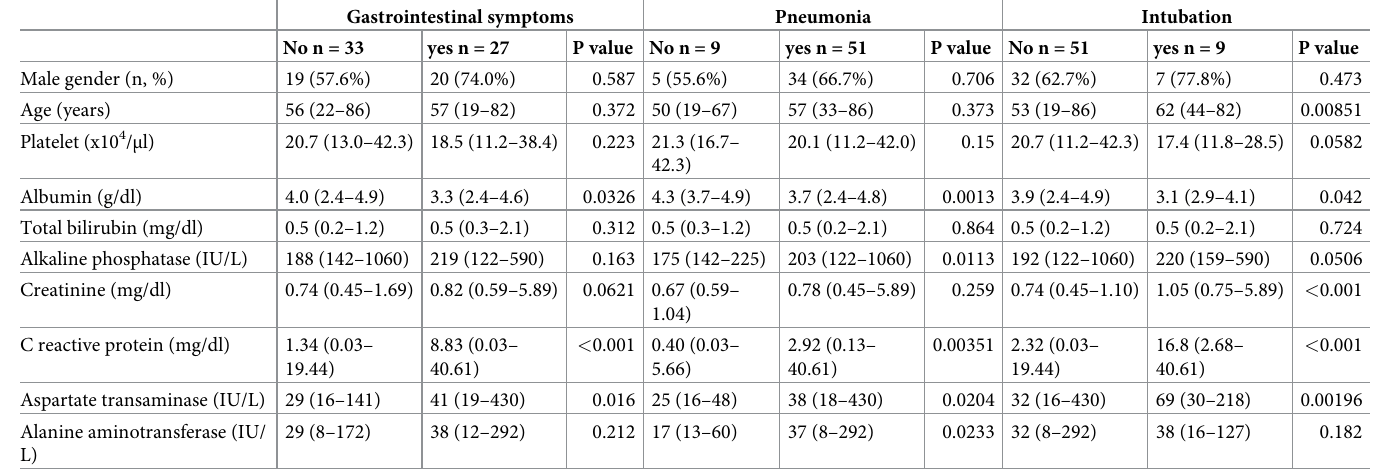
Table 3. Baseline characteristics of patients with COVID-19 classified with or without gastrointestinal symptoms, pneumonia, and intubation. Gastrointestinal symptoms Pneumonia